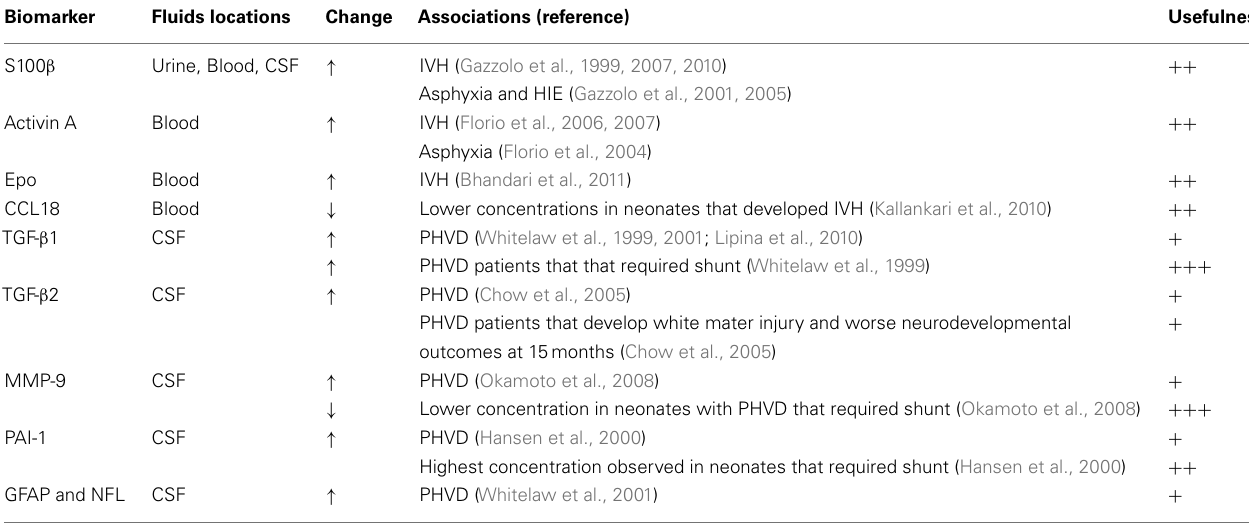
Table 2 | Most promising biomarkers and usefulness in neonatal brain